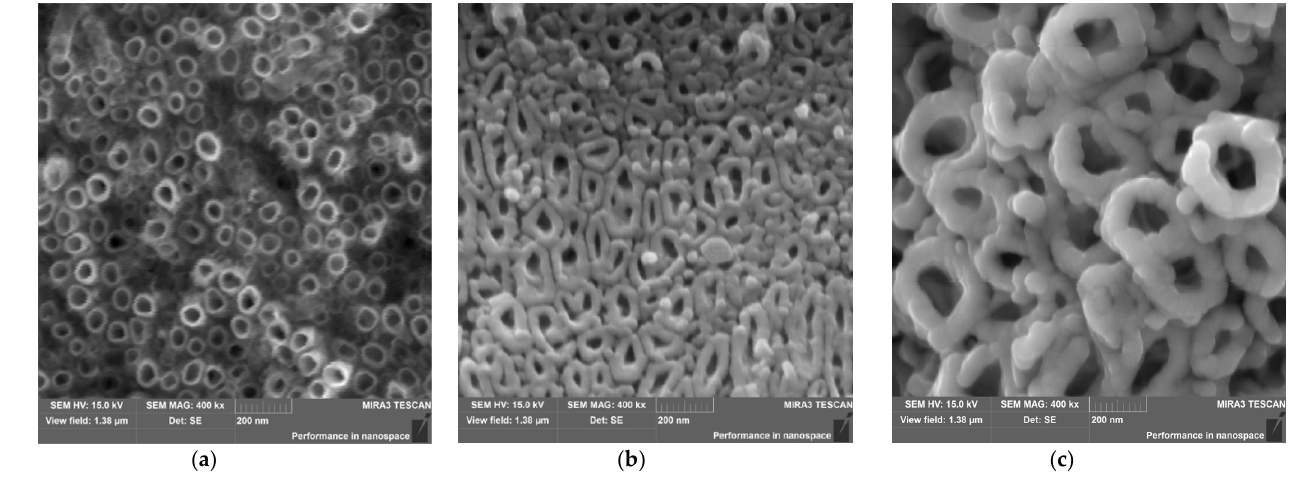
Figure 2. SEM image of the microstructure of ONT layer on the Ti–13Zr–13Nb alloy obtained by anodizing in: ( a ) 0.5% HF electrolyte (1G); ( b ) 1M (NH 4 ) 2 SO 4 + 2% NH 4 F electrolyte (2G); ( c ) 1M C 2 H 6 O 2 + 4% NH 4 F electrolyte (3G) .